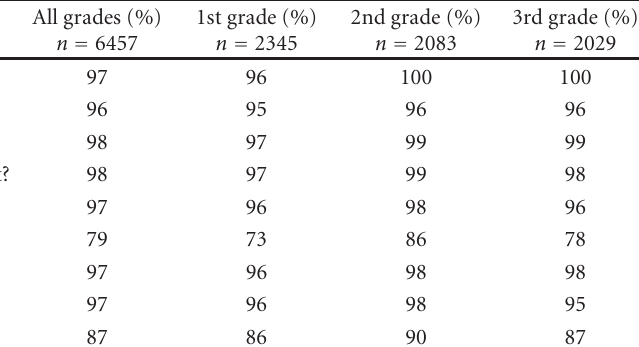
Table 2: Percentage of correct responses to poststudy questionnaire by